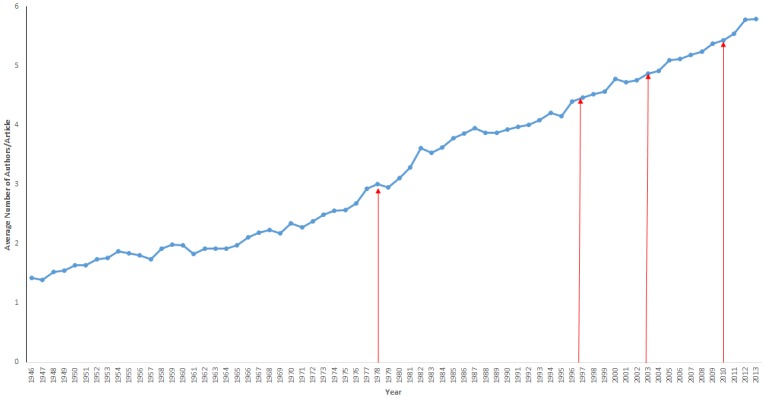
Overall mean number of authors/article for all included journals from 1946 to 2013.Analysis of mean authorship trends over time for radiology journals from 1946 to 2013. Time points for the implementation and major revisions to ICJME guidelines in 1979, 1997, 2003, 2010 and 2013 are denoted by red arrows.